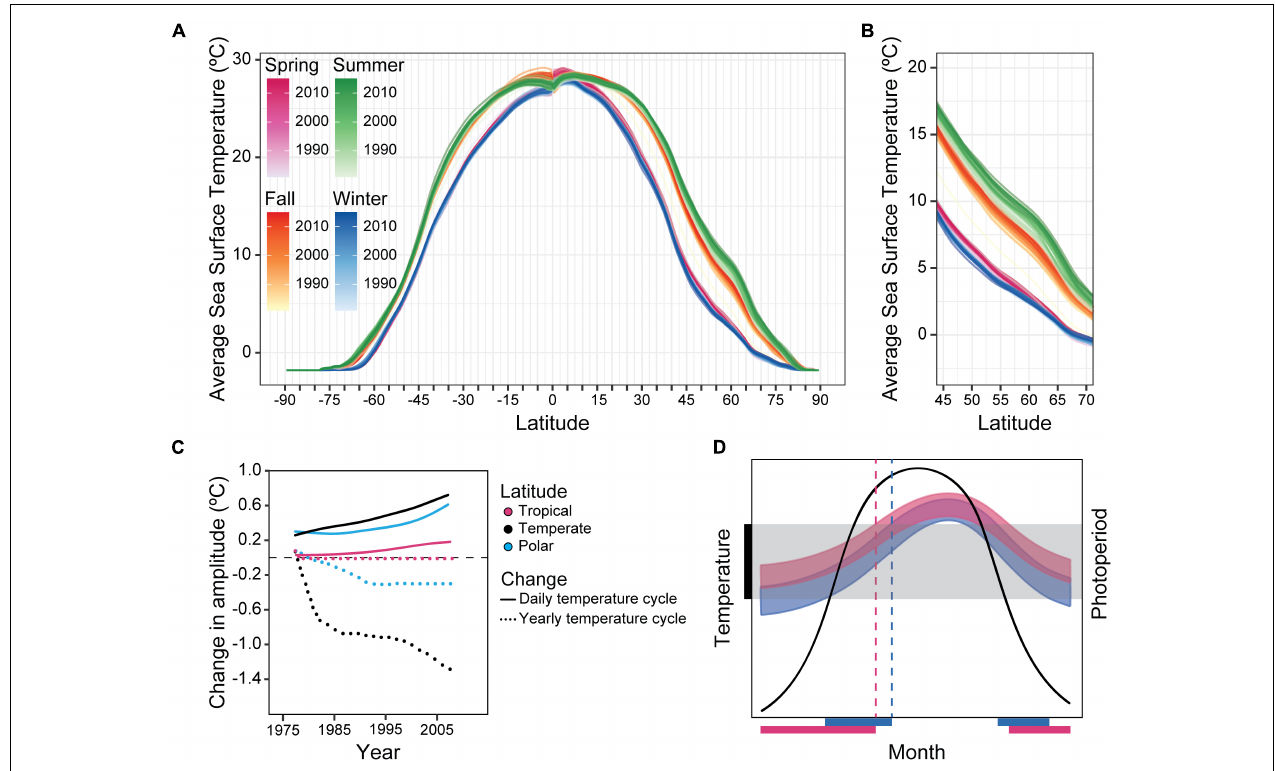
FIGURE 1 | Changes in temperature will likely affect temporal niches. (A) Average sea surface temperature ( ◦ C) across 34 years (1981–2015) for different latitudes, divided by seasons. Darker colours indicate more recent years. (B) Close-up of latitudes 45–70 from the first plot. For these latitudes, the effect of temperature increase seems to be the highest, particularly around summer and fall. In the summer, these temperature increases can be equivalent to a latitudinal shift of almost 5 ◦ toward the equator. The temperature data was provided by the NOAA/OAR/ESRL PSL, Boulder, CO, United States, OISST Version 2 (Reynolds et al., 2007), obtained through the International Research Institute/Lamont-Doherty Earth Observatory (IRI/LDEO) Climate Data Library. (C) Change in mean temperature and in the amplitude of the daily and yearly temperature cycle for different latitudinal bands. Data modified and redrawn from Wang and Dillon (2014). (D) Diagram showing the possible effects of an upwards shift in temperature in the temporal niche of a population. The central bell-shaped curve illustrates the annual change in photoperiod as a function of the month of the year. The black bar on the y -axis and the grey shaded area represents the temperature range tolerated by the species. Blue and pink curves represent the yearly temperature cycle for a “baseline” scenario (blue) and a scenario in which the average temperatures increase slightly but the yearly temperature variation decreases (pink), such as in the temperate zone in (C) . Blue and pink bars on the abscissa refer to the scenarios explained before and represent the time of the year in which that species is present (e.g., not in summer diapause), based on whether the temperature at the time is within its tolerated temperature range. Dashed lines indicate the photoperiod which anticipates a change from a thermally tolerable to a thermally intolerable